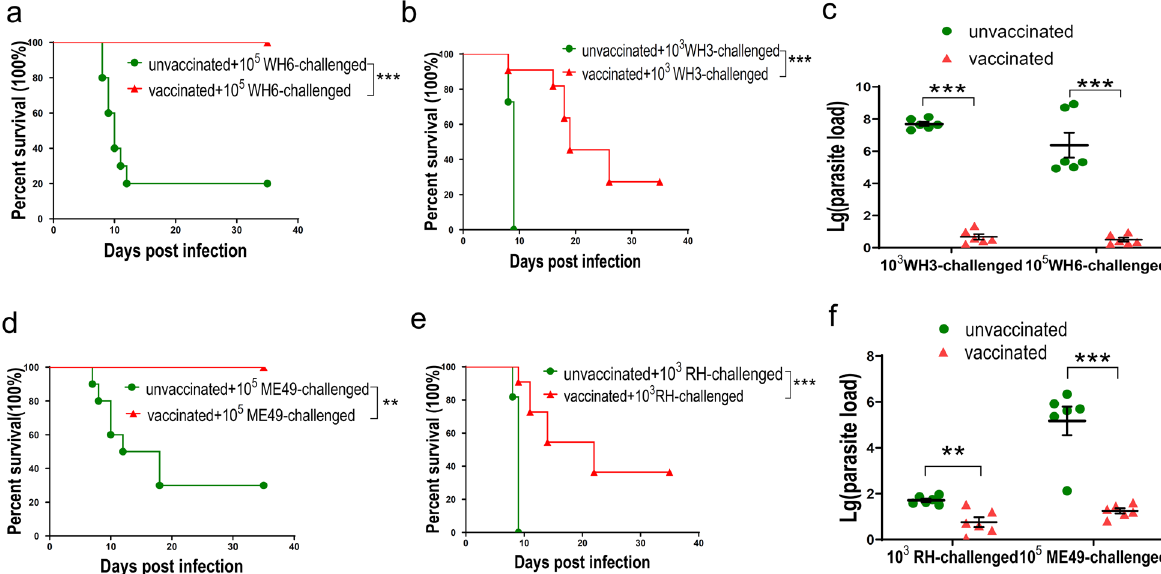
Fig. 3 Immunization with ME49 Δ cdpk3 vaccine protects mice from Toxoplasma tachyzoite infection. BALB/c mice were pre-immunized with 10 3 ME49 Δ cdpk3 tachyzoites. a , b 75 days after vaccination, they were respectively infected with a 10 5 WH6 strain tachyzoites, b 10 3 WH3 strain tachyzoites by intraperitoneal injection and their mortality was recorded for additional 35 days (10 mice for each strain). d – e 125 days after vaccination, they were respectively challenged with d 10 5 tachyzoites of the ME49 strains, e 10 3 tachyzoites of the RH strains by intraperitoneal injection and their mortality was recorded for additional 35 days (10 mice for each strain). Nonimmunized mice were considered as negative control. ** p < 0.01, *** p < 0.001. Gehan-Breslow-Wilcoxon tests. c , f Parasite loads in the peritoneal fl uid of vaccinated mice challenged with WH3, WH6, RH or ME49 tachyzoites. A quantitative PCR was used to determine parasites burdens in vaccinated and unvaccinated challenged mice at 7 days post-infection ( n = 6 each group). All statistical analyses were performed by using unpaired t test. Bars = mean ± SEM. Statistical differences are represented by *** p < 0.001, ** p <